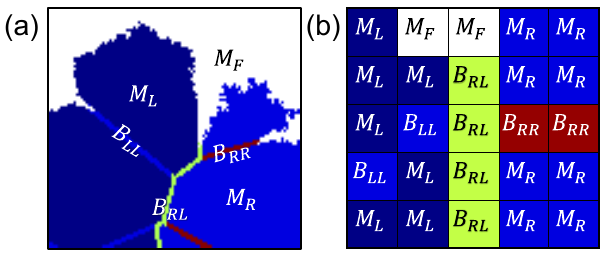
Figure 1. Part of the domain simulating a rock in the model at (a) the macro scale and (b) the pixel scale. The rock is simulated as a 2-D cross section using Voronoï tessellation. Grains are repre- sented as Voronoï cells containing a mineral phase, and cell edges represent the grain boundaries. Every element is given a character- istic value of either a fluid state ( M F , white), a high-reactivity grain ( M R , blue), a low-reactivity grain ( M L , dark blue), a grain boundary between two high-reactivity grains ( B RR , red), a boundary between two low-reactivity grains ( B LL , blue), or a boundary between one high-reactivity and one low-reactivity grain ( B RL ,